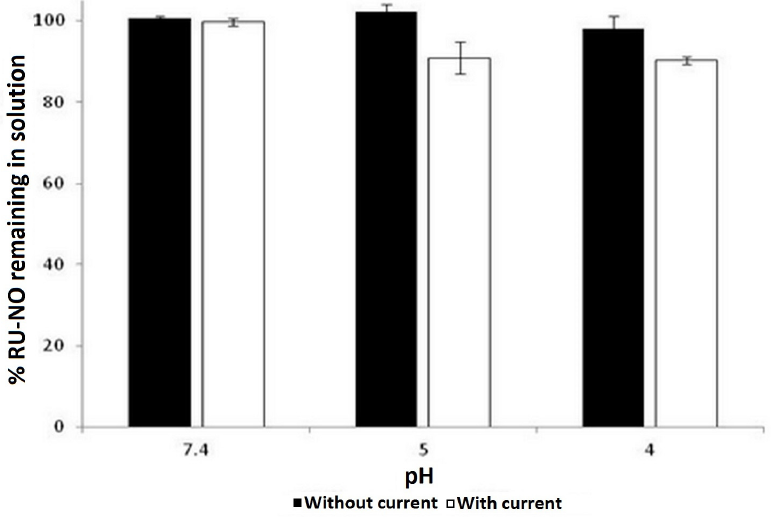
Figure 3. Stability of Ru ‐ NO complex under application of 0.4 mA electric current for 6 h.